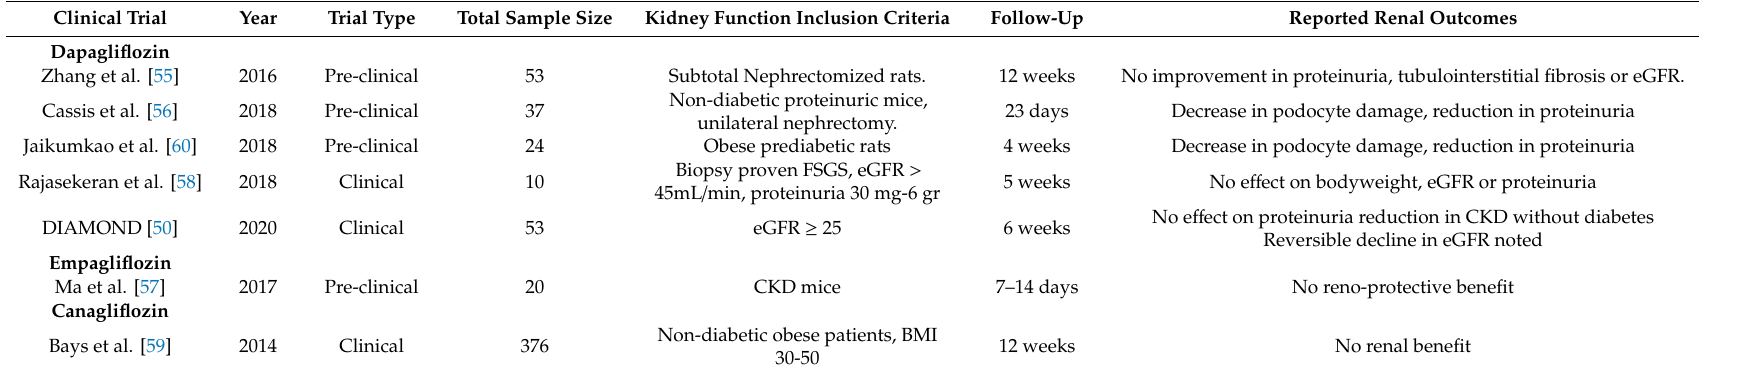
Table 2. Trials demonstrating the treatment outcomes of SGLT2 inhibitor in non-diabetics with chronic kidney